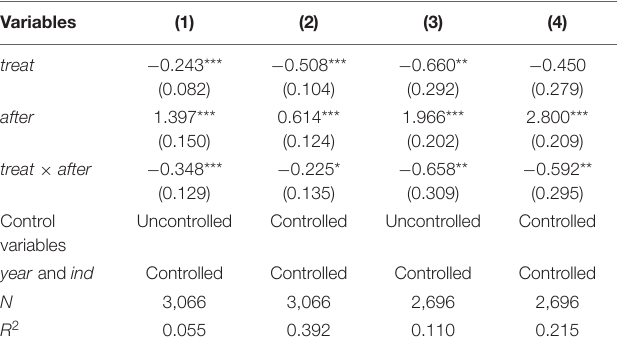
TABLE 8 | Robustness test of smog and enterprise